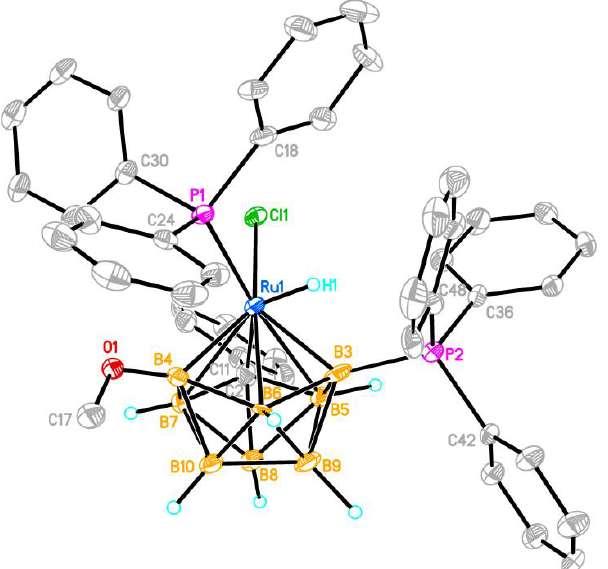
Figure 2. Molecular structure of the complex 5a (only the hydrogen atoms of the hydride ligand and carborane moiety are shown; thermal ellipsoids are drawn at the 30% probability level). Selected interatomic distances (Å) are: Ru(1)-Cl(1) 2.411(3), Ru(1)-P(1) 2.351(3), Ru(1)-H(1) 1.34, Ru(1)-C(2) 2.181(11), Ru(1)-B(7) 2.516(12), Ru(1)-B(5) 2.449(11), Ru(1)-B(4) 2.095(11), Ru(1)-B(3) 2.072(11), Ru(1)-B(6) 2.364(9), P(2)-B(3) 1.889(13), C(2)-C(11) 1.478(15).